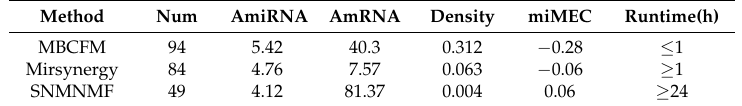
Table 1. Performance summary of MBCFM, Mirsynergy and